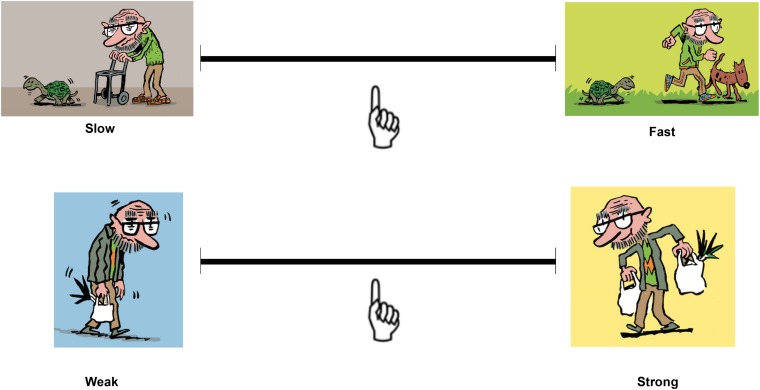
Two examples of the Young Children’s Views of Older People (YCVOP) scale. The child has to slide a handle and point the finger at a position that best describes her/his view of older people on the line between two opposed adjectives, each illustrated by a cartoon.